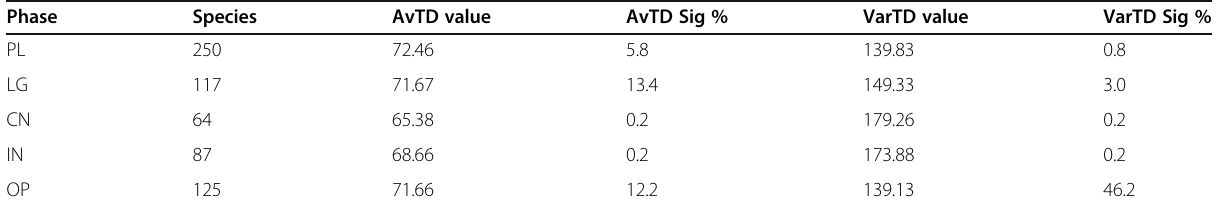
Table 3 Average taxonomic distinctness (AvTD) and variation in taxonomic distinctness (VarTD) values across dam development phases throughout 10 years study in Puah Lake Catchment, Hulu Terengganu, Peninsular Malaysia, calculated using the